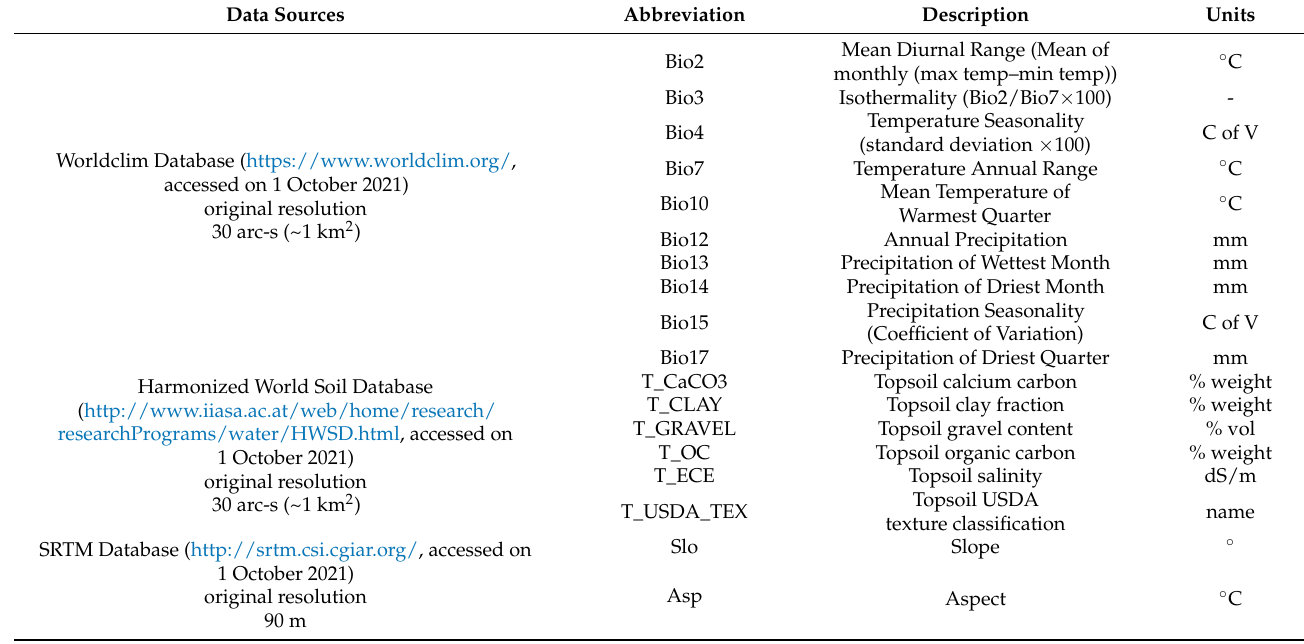
Table 2. List of environmental predictors used for modeling the habitat suitability distribution of four Rhododendron species.